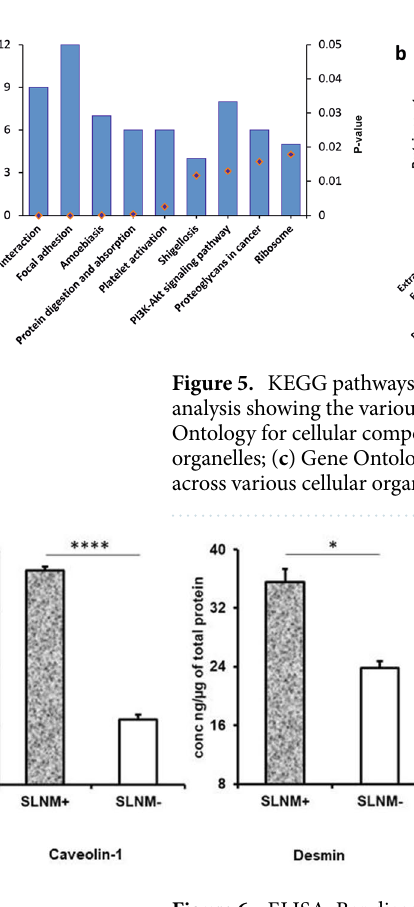
Figure 6. ELISA. Bar diagrams showing the ratio of protein expression of ( a ) caveolin-1, ( b ) desmin, ( c ) microfibrillar associated glycoprotein 4 ( d ) collagen α − 1, and ( e ) fibrillin-1 in metastatic patients (black) and non-metastatic patients (grey). *indicates P < 0.05; ****indicates P <